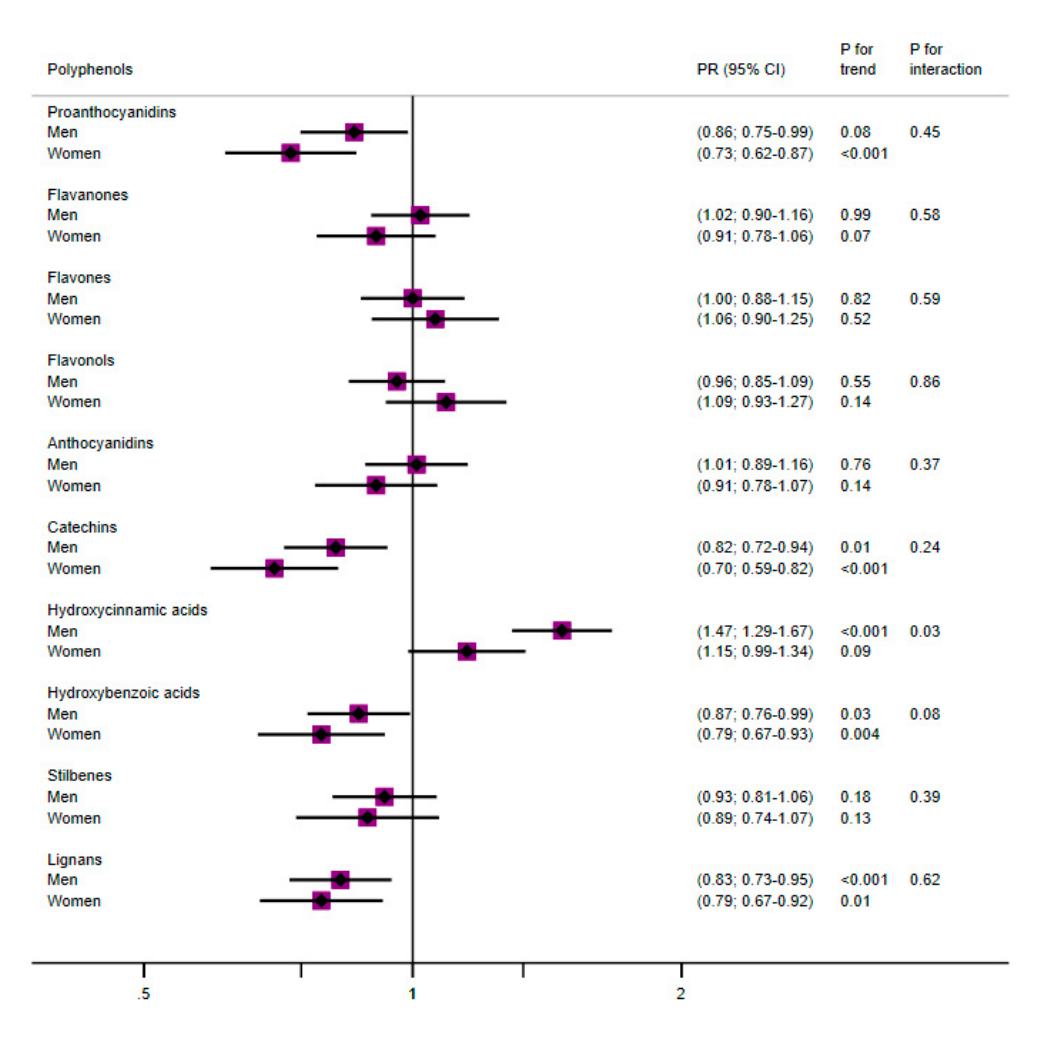
Figure 1. Cox proportional models for polyphenol groups and type 2 diabetes (T2D) by sex, comparing quartile 4 (Q4) vs. quartile 1 (Q1) and adjusted for age, education (basic studies, medium, high), body mass index (BMI) (overweight, obese), smoking (never, former, smoker), physical activity (quintiles), energy, consumption of refined cereals and animal products (from 17-point questionnaire) and of distilled beverages and liquors, sugar, soft drinks, cookies, and pastries (g / day), and stratified by recruitment center.